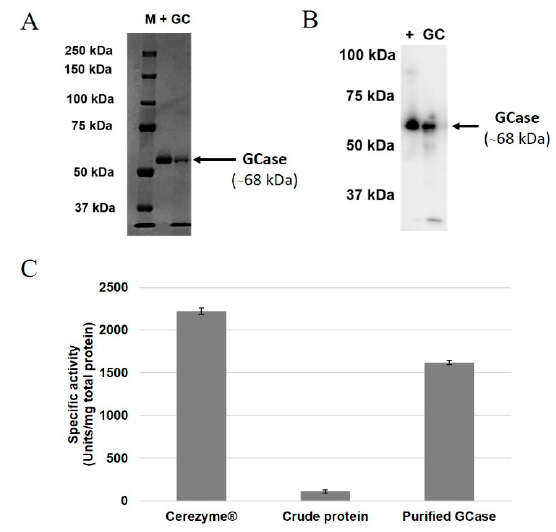
Figure 3. Analysis of purified GCase extracted from root culture. ( A ) SDS-PAGE analysis, ( B ) Western blot analysis, and ( C ) GCase enzymatic activity. Primary antibody, anti-GCase from rabbit; secondary antibody, anti-rabbit-IgG, horseradish peroxidase (HRP)-linked. M, precision plus protein standards marker; +, Cerezyme ® ; WT, wild type; GC, GCase. Arrows indicate the GCase band (68 kDa ).